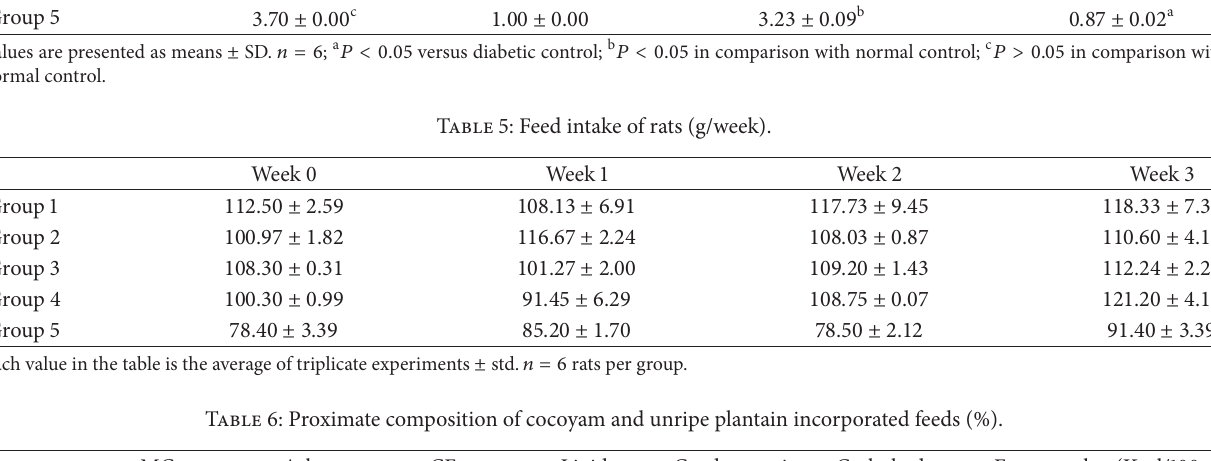
Table 6: Proximate composition of cocoyam and unripe plantain incorporated feeds (%).